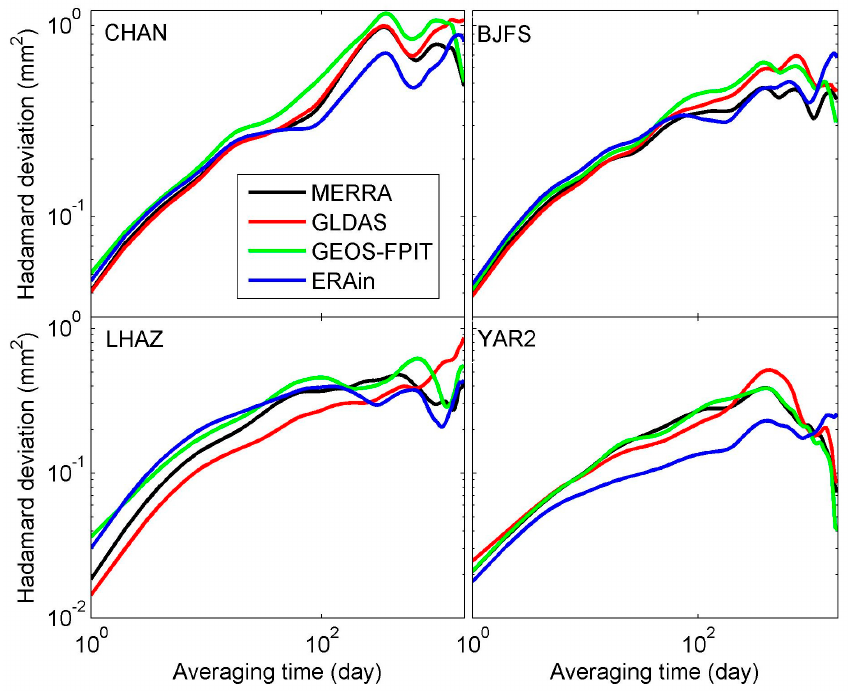
Figure 3. Overlapping Hadamard variance of hydrology loading predictions (variation fits near 1, 2, 3, and 4 cpy were removed) at the sites of CHAN, BJFS, LHAZ, and YAR2. Error bars of Hadamard variance were omitted for clarity.